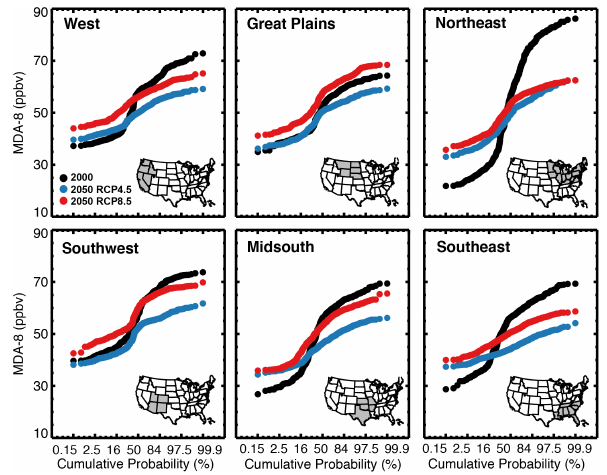
Figure 11. Cumulative probability distributions of simulated sur- face O 3 MDA-8 averaged over the US national parks and wilder- ness areas in the US climatic regions, for present-day (black circles) and 2050 predicted by the RCP4.5 (blue circles) and RCP8.5 (red circles) scenarios. The inset maps show the states in the region in gray.